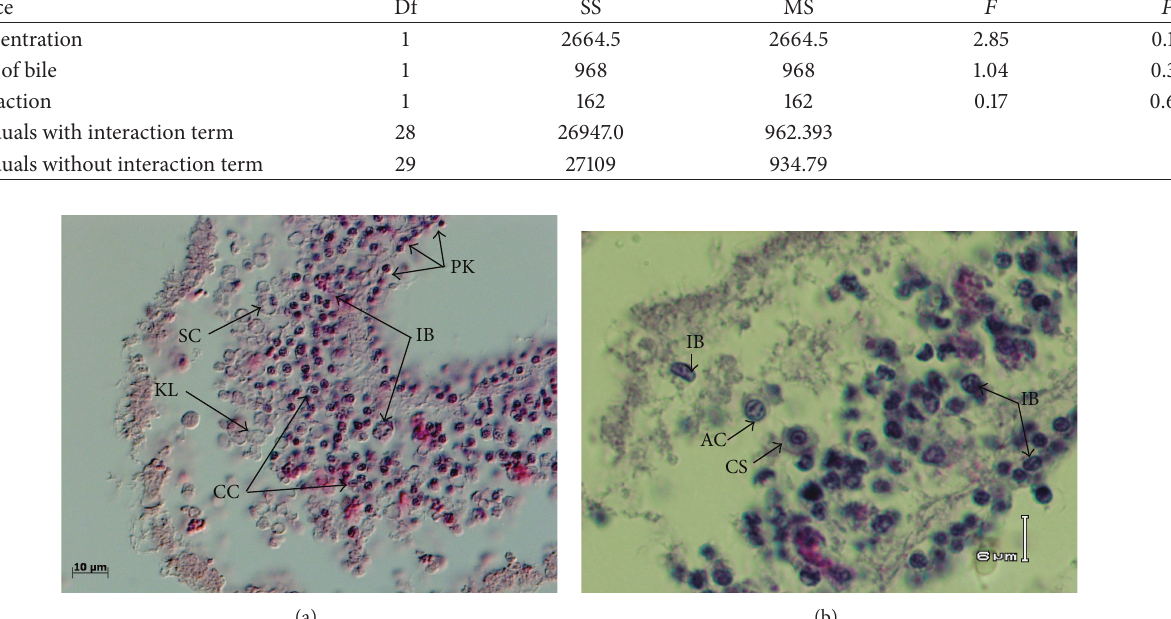
Figure 2: Histological changes related to apoptotic and necrotic processes were observed in Acanthaster planci injected with bile salts. (a) Pyknosis (PK); intracellular bodies (IB); cell swelling (CS); karyolysis (KL); initial stages of chromatin condensation (CC). (b) Apoptotic cells (AC) with condensed and hyperchromatic chromatin and fragmented nuclei; cell swelling (CS); intracellular bodies (IB).